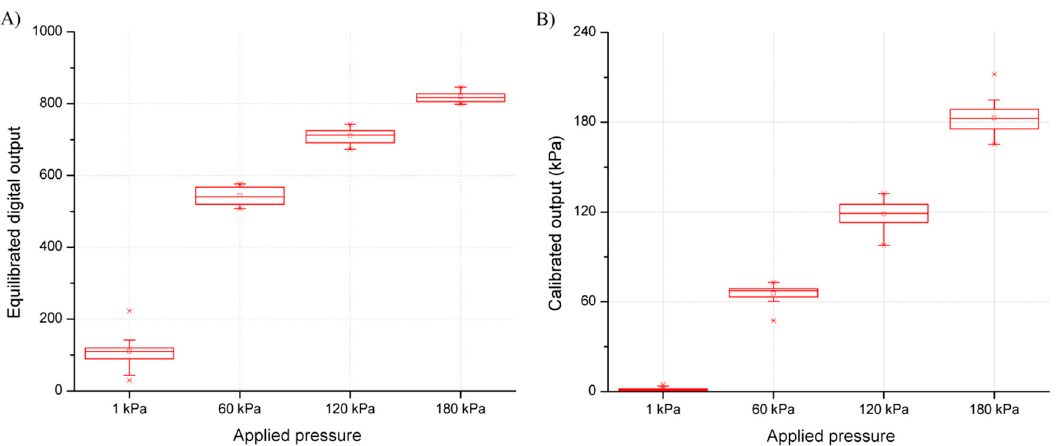
Figure 8. Boxplot of the equilibrated digital readout ( A ) and calibrated pressure output of 16 different sensels of the mat prototype ( B ).